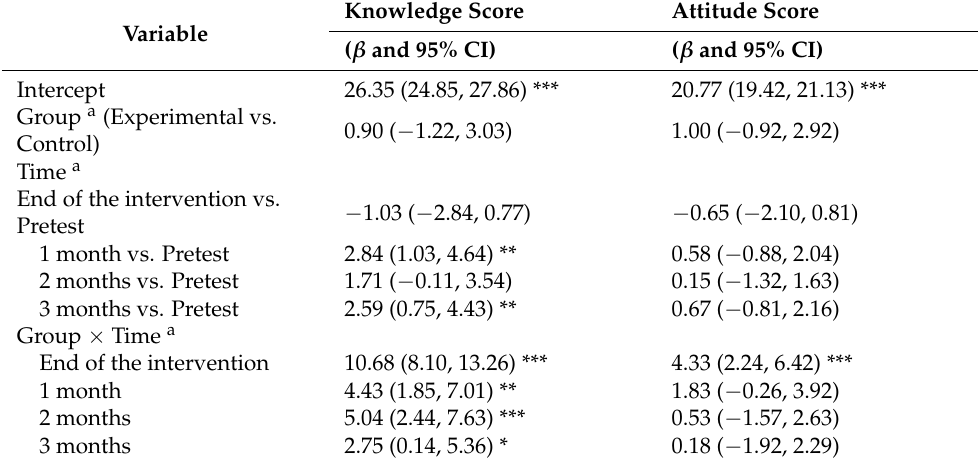
Table 3. Analysis of changes in knowledge and attitudes after the educational intervention via